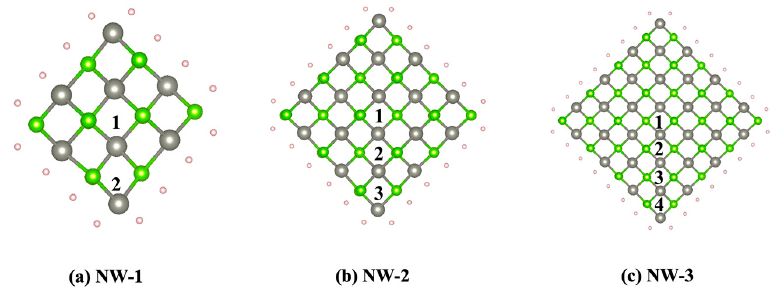
Figure 1. Top view of ZnSe NWs along the [001] direction with different diameters: ( a ) NW-1(8.5 Å), ( b ) NW-2(14.2 Å), ( c ) NW-3(19.8 Å). Green and grey atoms are Se and Zn atoms, red and blue atoms are H1.5 and H0.5 atoms, respectively.